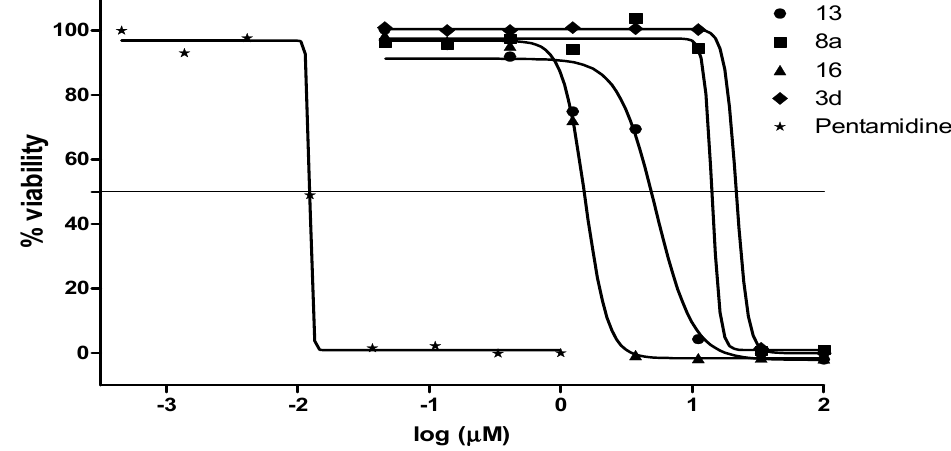
Figure 4. Dose-response curves of compounds active against T.b. brucei compared with pentamidine.